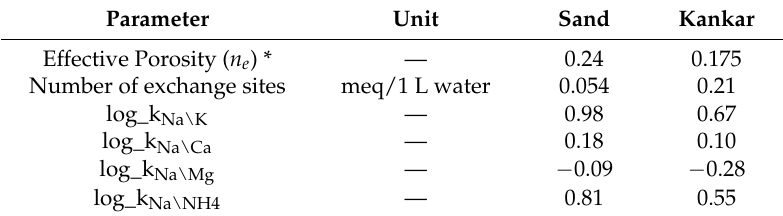
Table 3. Transport parameters used in the 1D reactive transport models (modified after